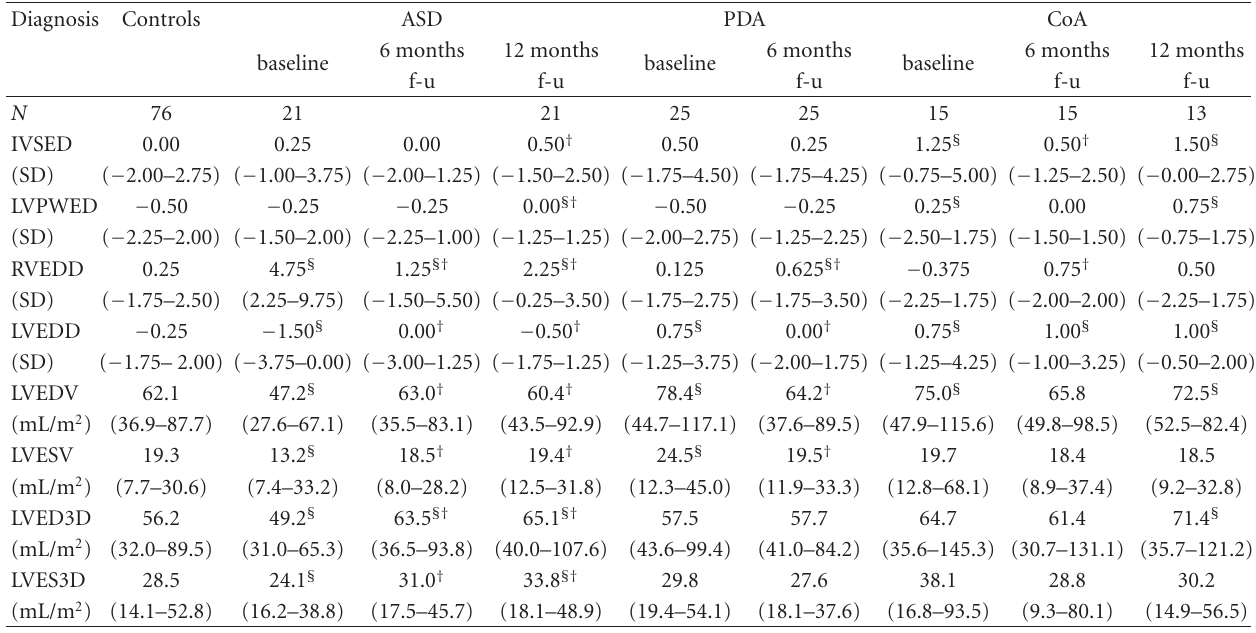
Table 3: Two- and three-dimensional echocardiographic findings in control subjects and in groups of children with ASD, PDA, and CoA, measured at baseline and at 6 and 12 months after repair. Values are given as median